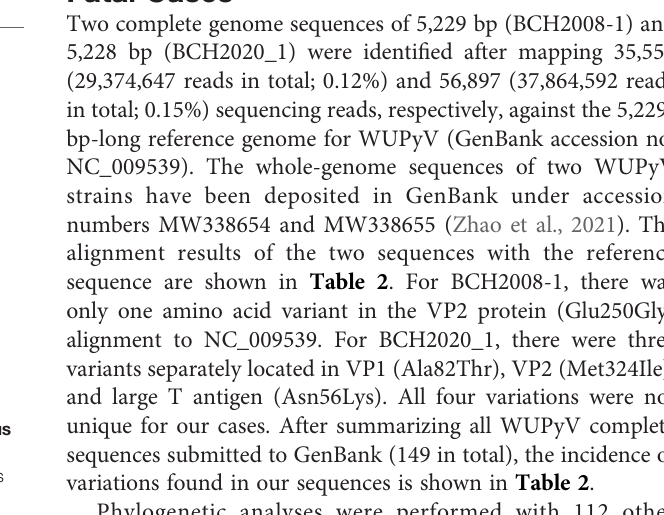
TABLE 1 | Laboratory detection and mNGS results of the two fatal